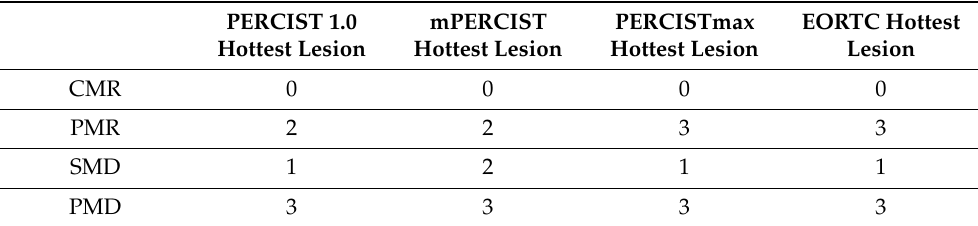
Table 5. Number of deaths during lenvatinib treatment depending on metabolic response according to all PERCIST criteria and EORTC (hottest